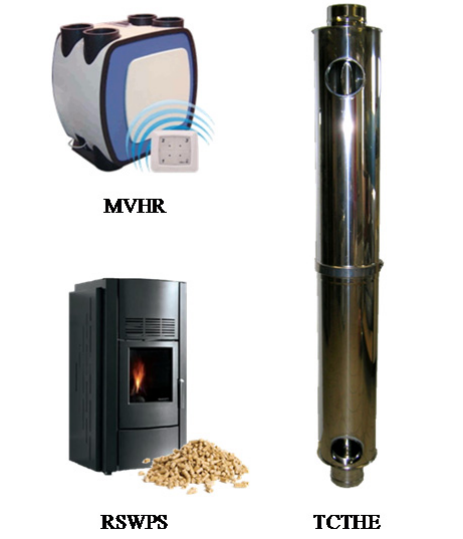
Figure 1. View of the three main components of the combined